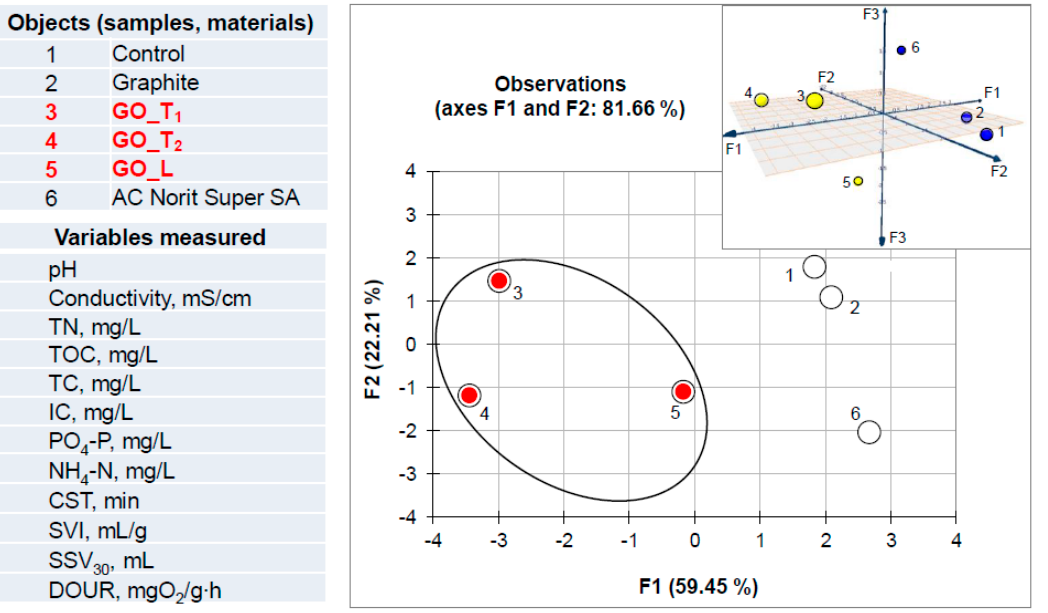
Figure 7. Projection of the objects set in 2D and 3D factor score spaces concerning PCA analysis of data matrix, related to the experiment involving wastewater and activated sludge with carbon materials.